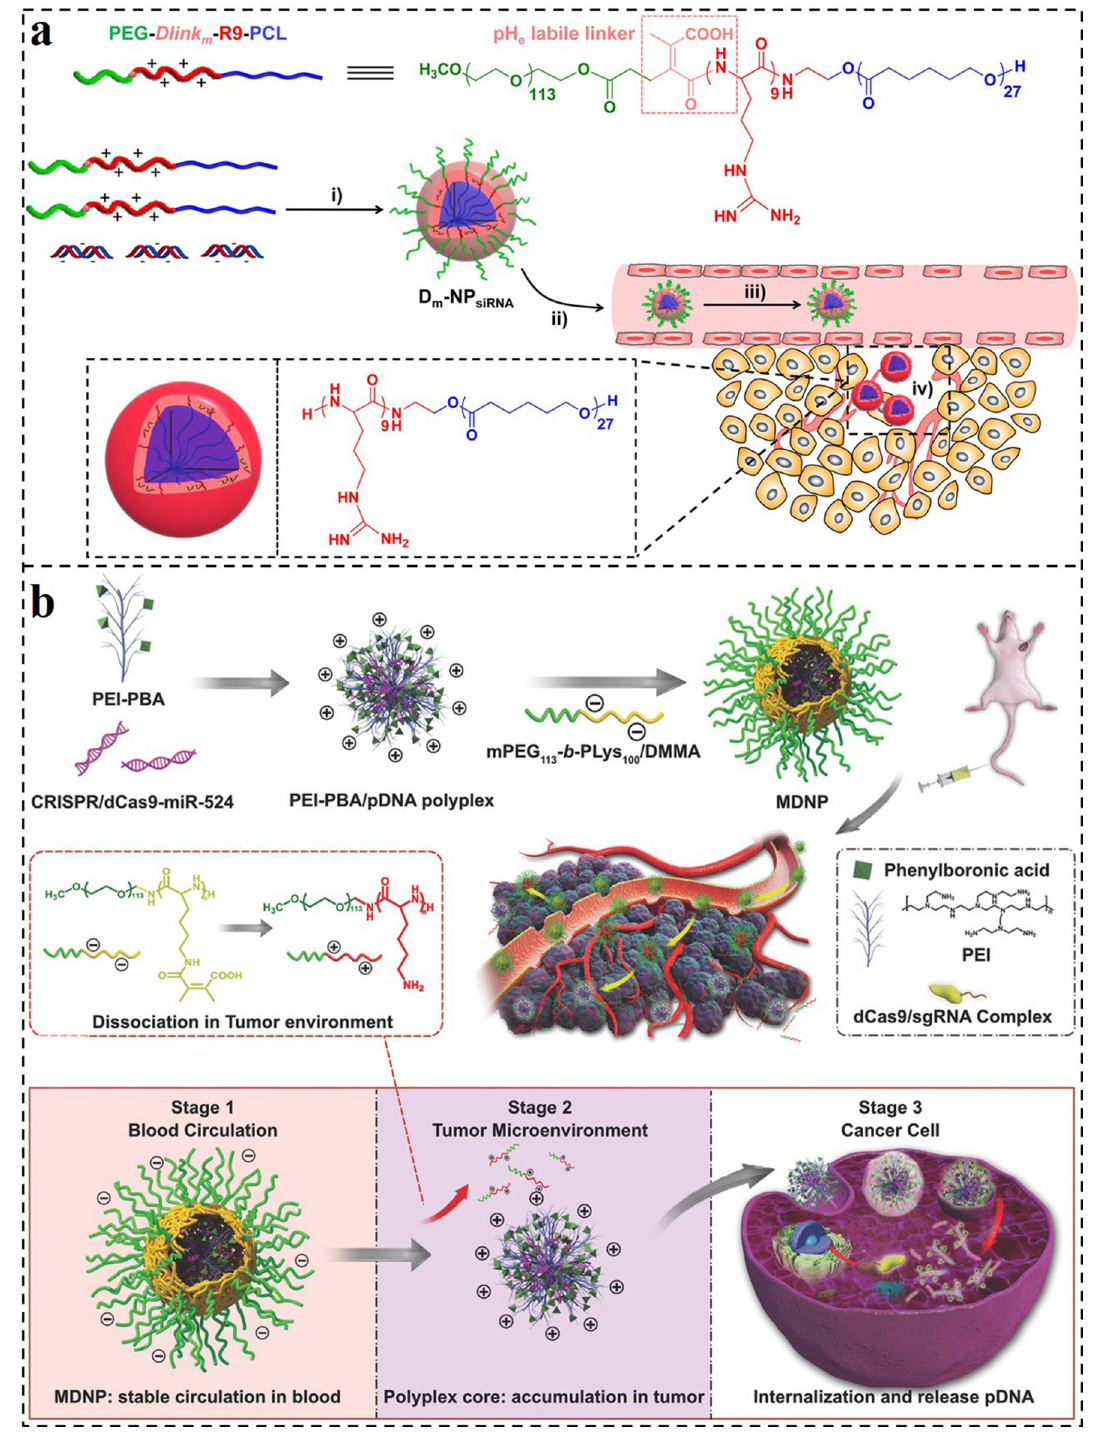
Fig. 3 a Illustration of the self-assembly of PEG- Dlink m -R9-PCL, formation of D m -NPsiRNA, and systemic administration of D m -NPsiRNA [153]. Copyright 2015, American Chemical Society. b Schematic illustration for the preparation of MDNP and delivery process after intravenous injection [154]. Copyright 2018, Wiley–VCH